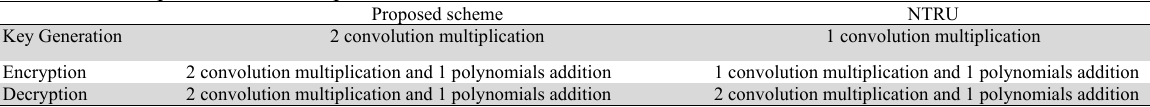
The Arithmetic Operation of the Proposed Scheme and the